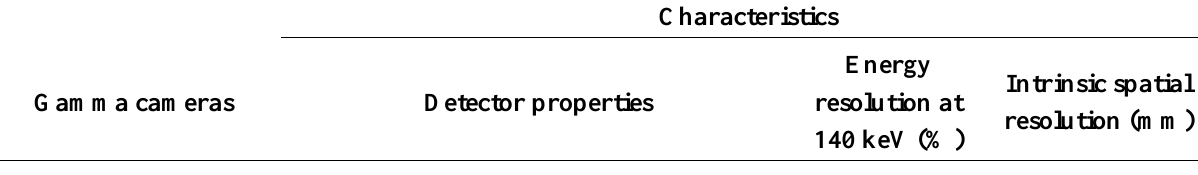
Table 2. Characteristics of gamma cameras based on NaI(Tl) and CdTe/CdZnTe detectors.